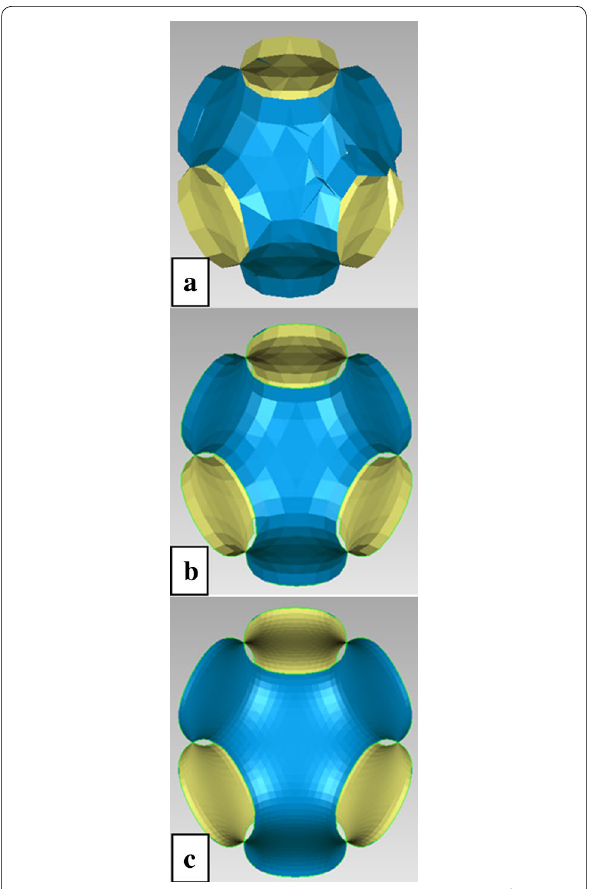
Figure 1 Surface models of bone scaffolds: a 560 points/mm 2 , b 1120 points/mm 2 , c 5600 points/mm 2